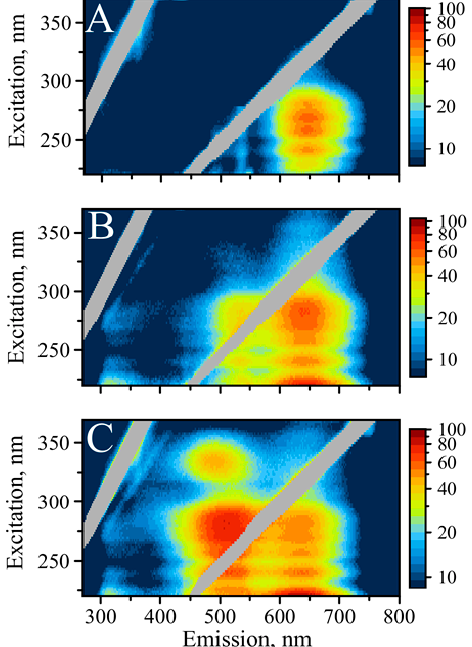
Figure 2. Excitation / emission maps of silver nanoclusters with excitation in UV: ( A ) AgNC templated on C 12 , ( B ) AgNC templated on SD9-OEC 12 , ( C ) AgNC templated on SD9-BEC 12 .